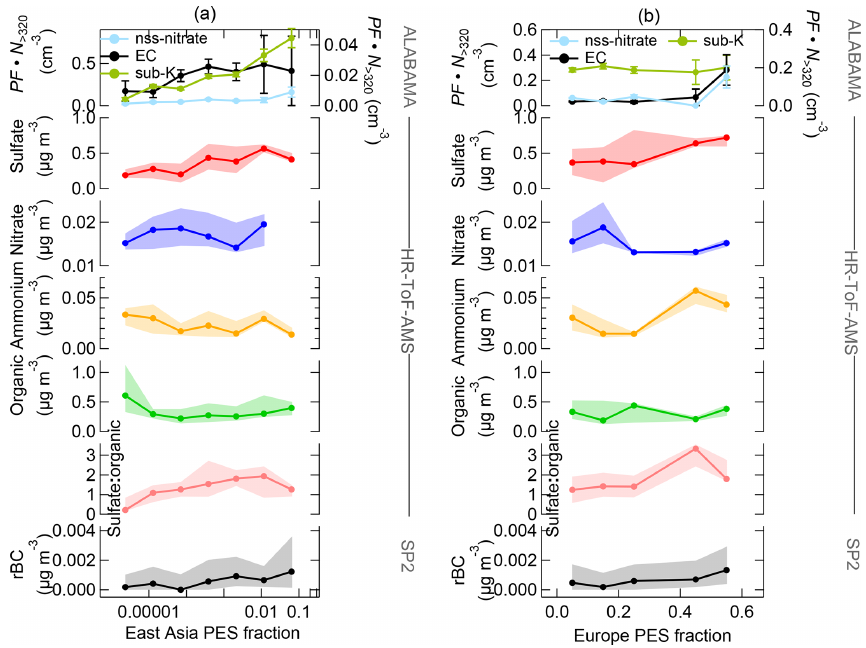
Figure 13. Aerosol composition measured by the ALABAMA, by the HR-ToF-AMS, and by the SP2 (indicated on the right side) as a function of FLEXPART-derived PES fraction over East Asia (a) and Europe (b) during the Arctic air mass period. The top panel represents each the scaled ALABAMA number concentration (PF · N > 320 ), with the right axis referring to EC-containing particles (black) and the left axis referring to nss-nitrate-containing particles (light blue) and sub-K-containing particles (green). The lower panels represent each median (solid line with marker) and interquartile range (shaded area) of the HR-ToF-AMS mass concentrations of sulfate (red), nitrate (blue), ammonium (orange), organic matter (light green), and the sulfate-to-organic ratio (pink), as well as the SP2 mass concentration of refractory black carbon (rBC) (black). Uncertainty analyses are given in Sect.